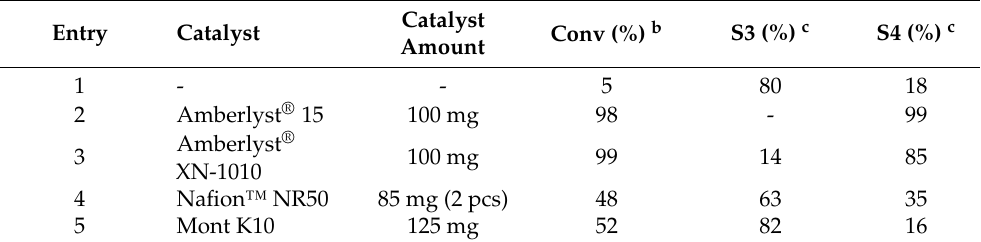
Table 5. Influence of the catalyst in the mechanochemical reaction of 1 and 2 a